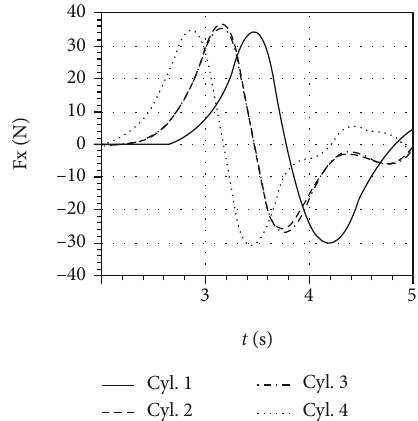
Figure 9: Time evolution of the in-line force on the diamond arrangement for H / h = 0 : 25